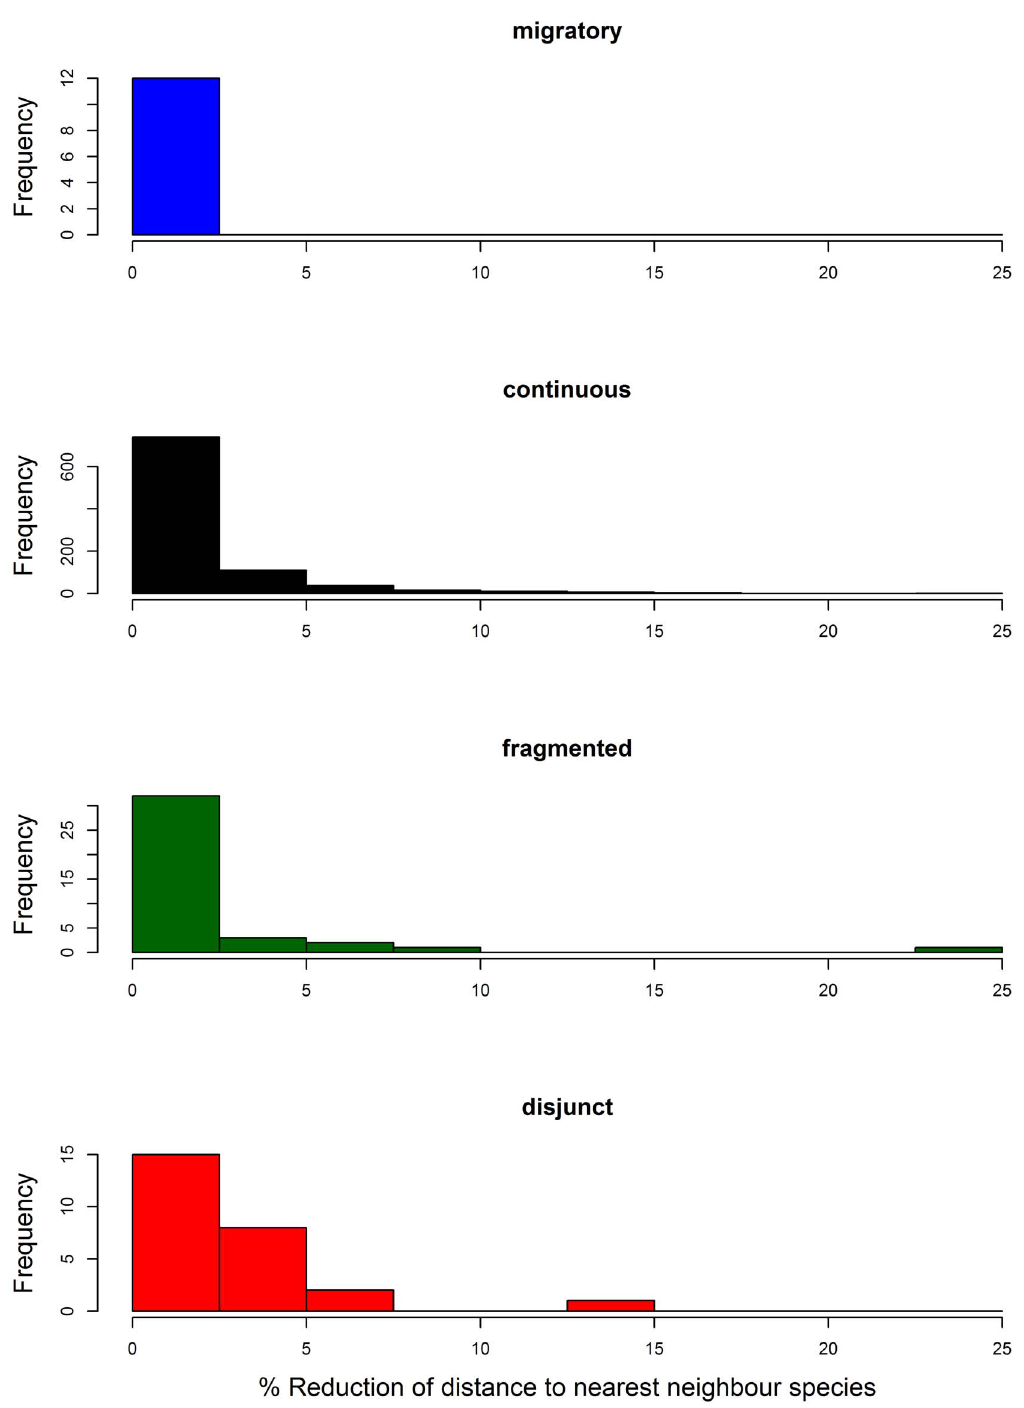
Fig. 7. Effect of increased geographical sampling on nearest neighbor (NN) distance for species in each of four distribution categories. Histograms show the % reduction in minimum NN distance after addition of the Austrian samples. This figure excludes one species pair ( Anacampsis blattariella and A. populella ) in the continuous distribution category that showed a 75% reduction in NN distance with the addition of the Austrian samples.